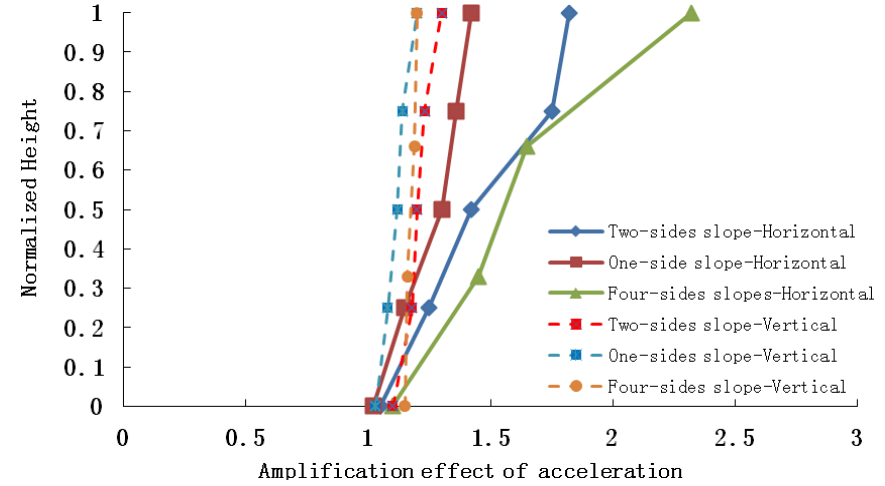
Figure 12. Horizontal and vertical acceleration amplifications when the input is PGA = 0.2 g.